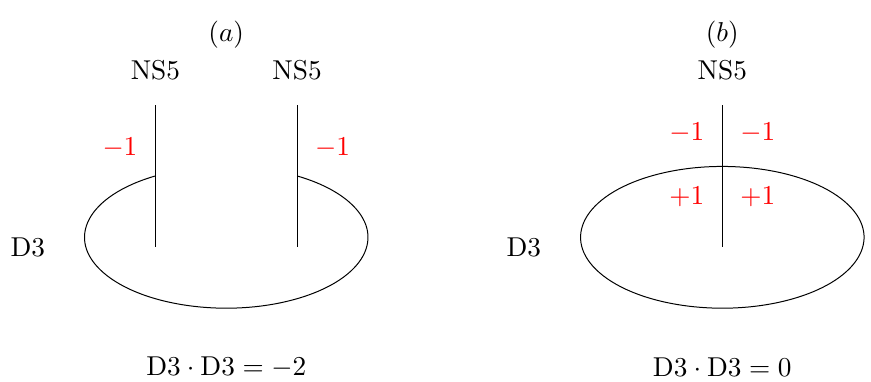
Figure 9. Two configurations of D3 and NS5 branes on a circle. The self-intersection of the D3 brane is computed by adding the contributions in